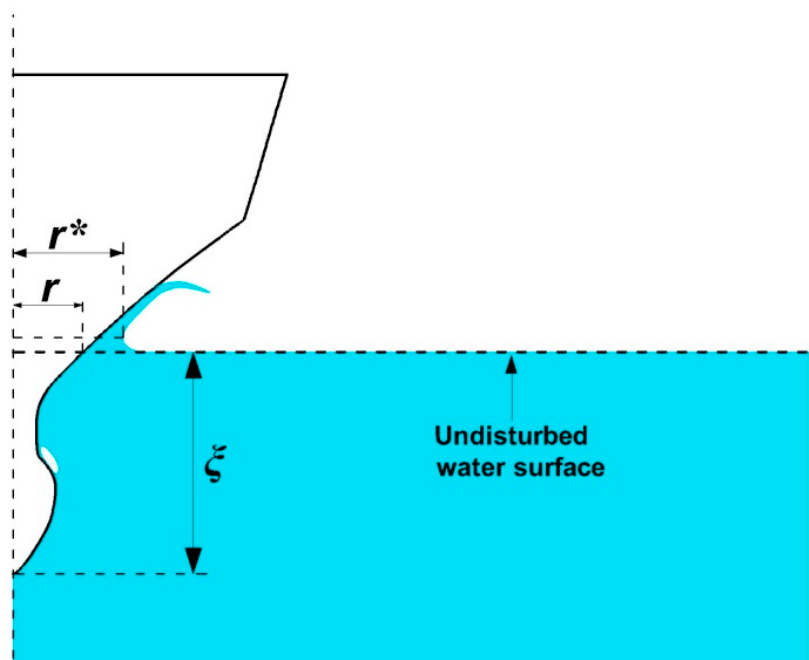
Figure 16. The wetted length r* and the reference wetted length r corresponding to the penetration depth ξ .